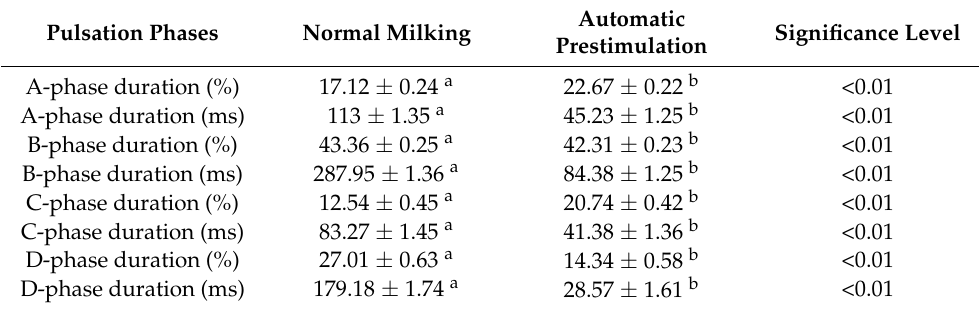
Table 4. Effect of the treatment (normal milking, 90 cycles per min, vs. milking with automatic prestimulation, 300 cycles per min) on the pulsation phases during the mechanical milking of Murciano-Granadina goats on the onset of lactation (least square means ± standard error of the